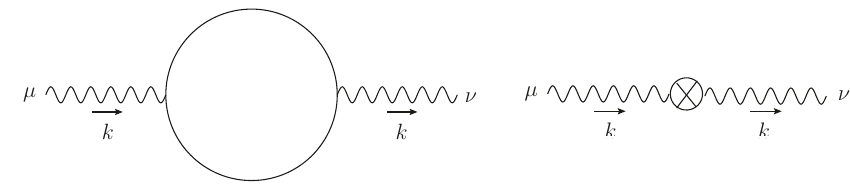
Figure 3 . Leading contributions to the vacuum polarization i (cid:22)(cid:5) (cid:22)(cid:23) . [Left] fermion loop i (cid:5) (cid:22)(cid:23) . [Right] counter